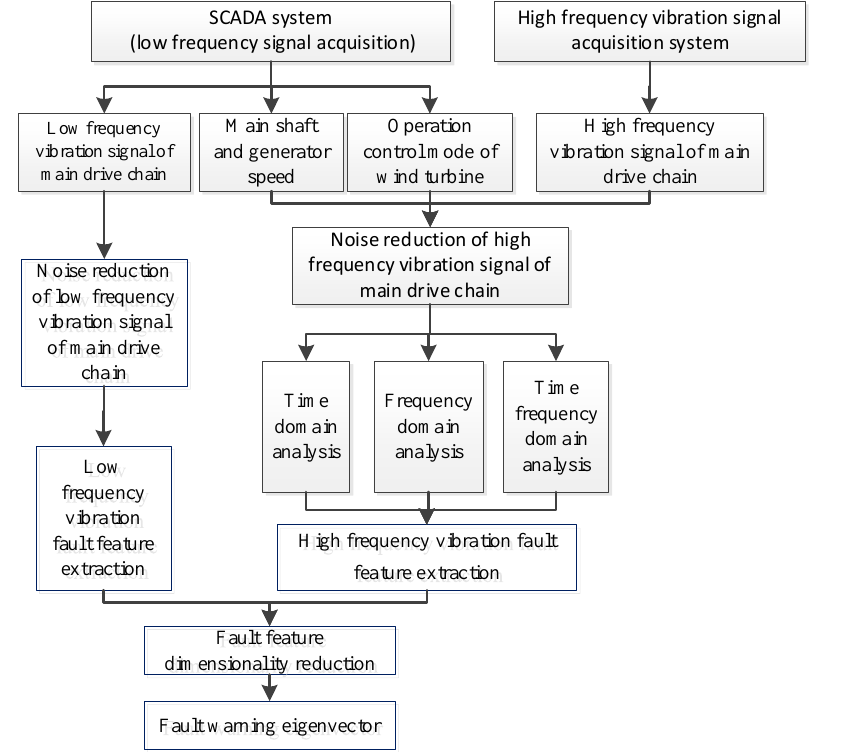
Figure 4. Process of fault feature extraction based on fusion of two types of data.